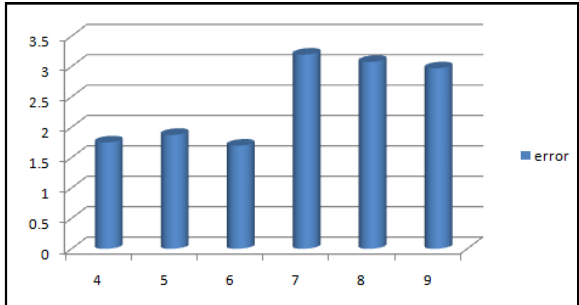
Figure 7. RTK GPS from Known GPS Station (10